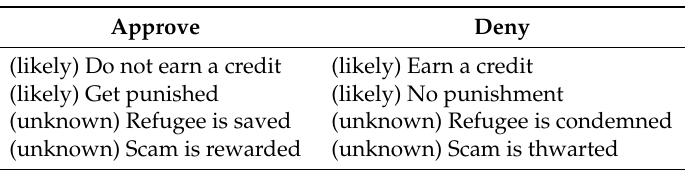
Table 4. Likelihood analysis for the choice shown in Figure